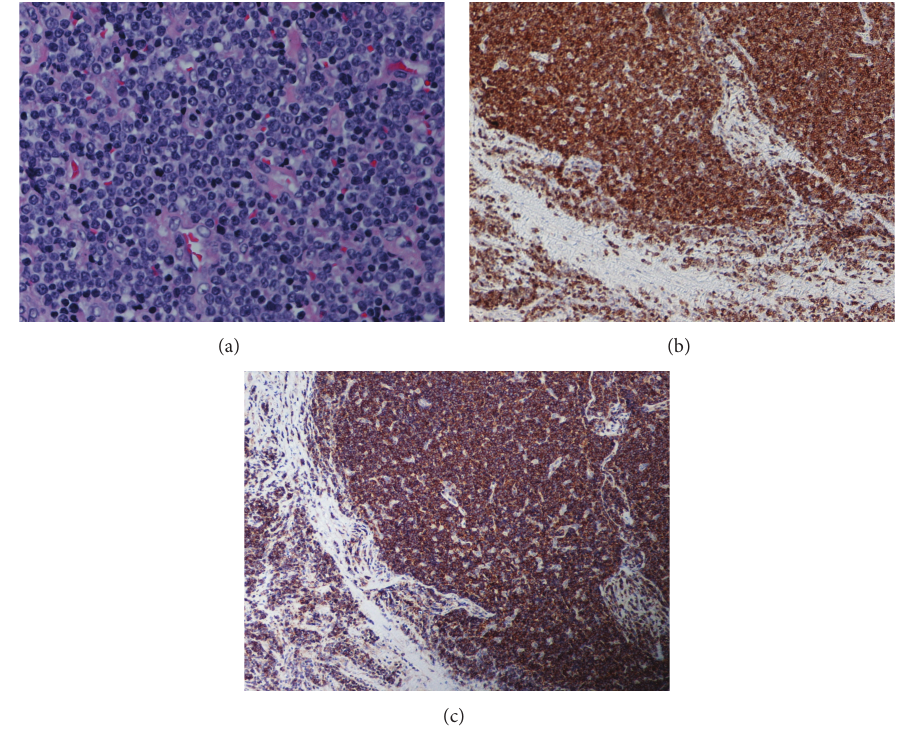
Figure 1: Supraclavicular lymph node biopsy ((a) H&E, 40x; (b) IHC stain for CD3, 10x; (c) IHC stain for CD99,